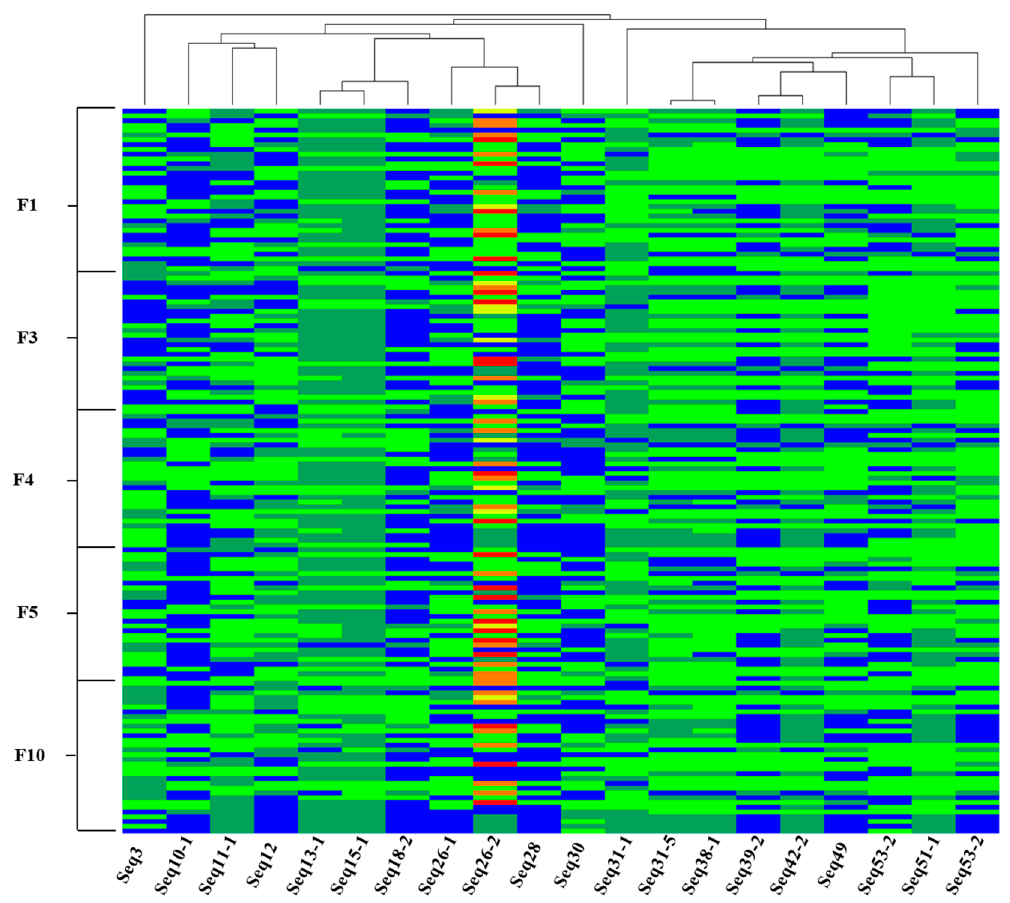
Figure 4. Heat map of the genotype distribution profile of the five rare minnow closed colonies.